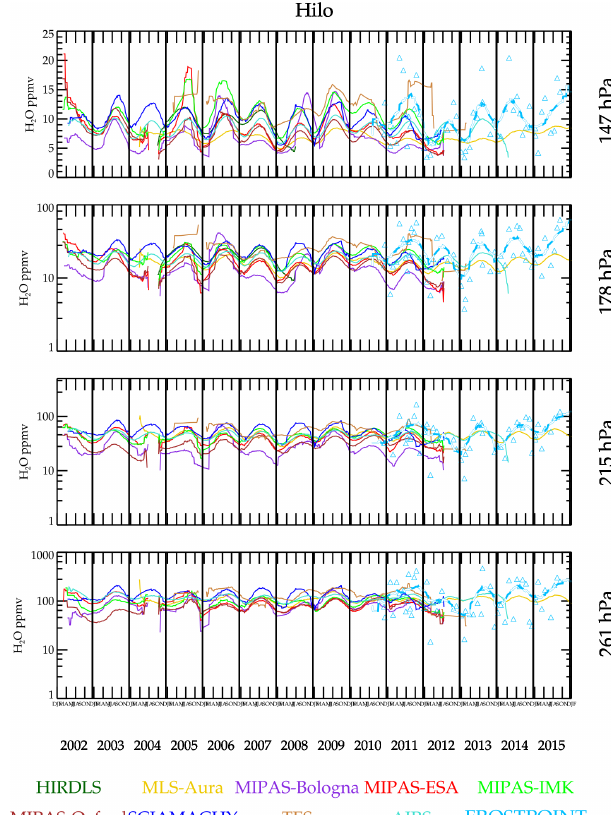
Figure 7. Time series of BFH and satellite and retrievals having enough data coincident with Boulder to produce a smoothed time series curve. The BFH data show the individual measurements in addition to the smoothed curve. Only smoothed curves are shown for the data sets to remove excessive data clutter.